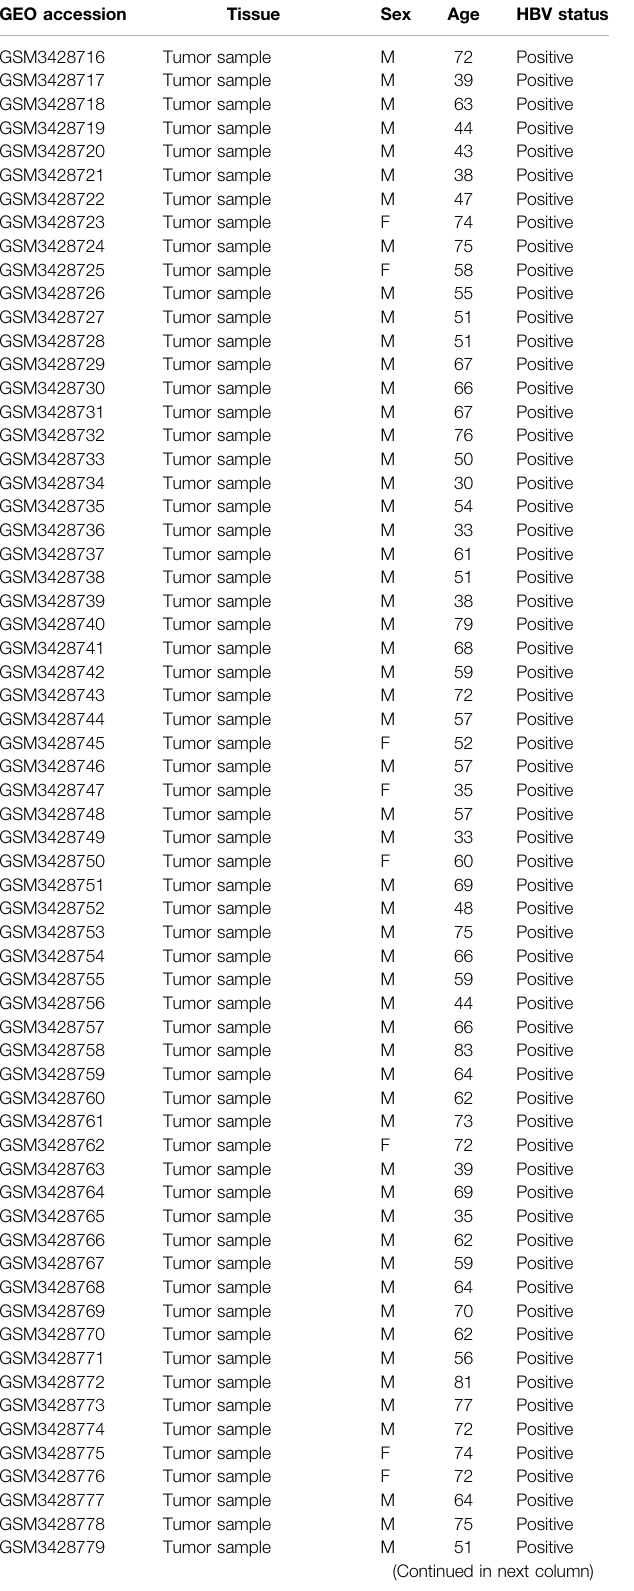
TABLE 1 | Basic features of the GSE121248 data